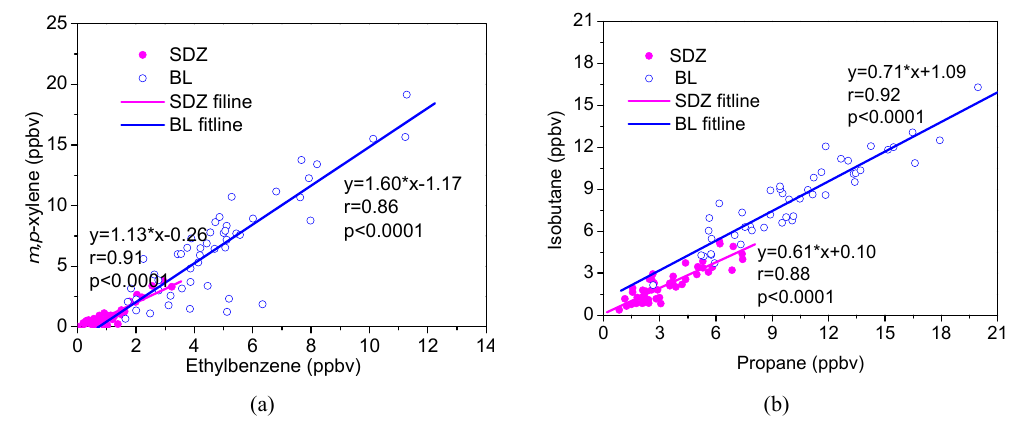
Fig. 11. Scatter plots of (a) m,p -Xylene to ethylbenzene and (b) isobutane to propane at BL and SDZ sites. Fig.11. Scatter plots of (a) m, p -Xylene to ethylbenzene and (b) isobutane to propane at BL 2 and SDZ sites. 3